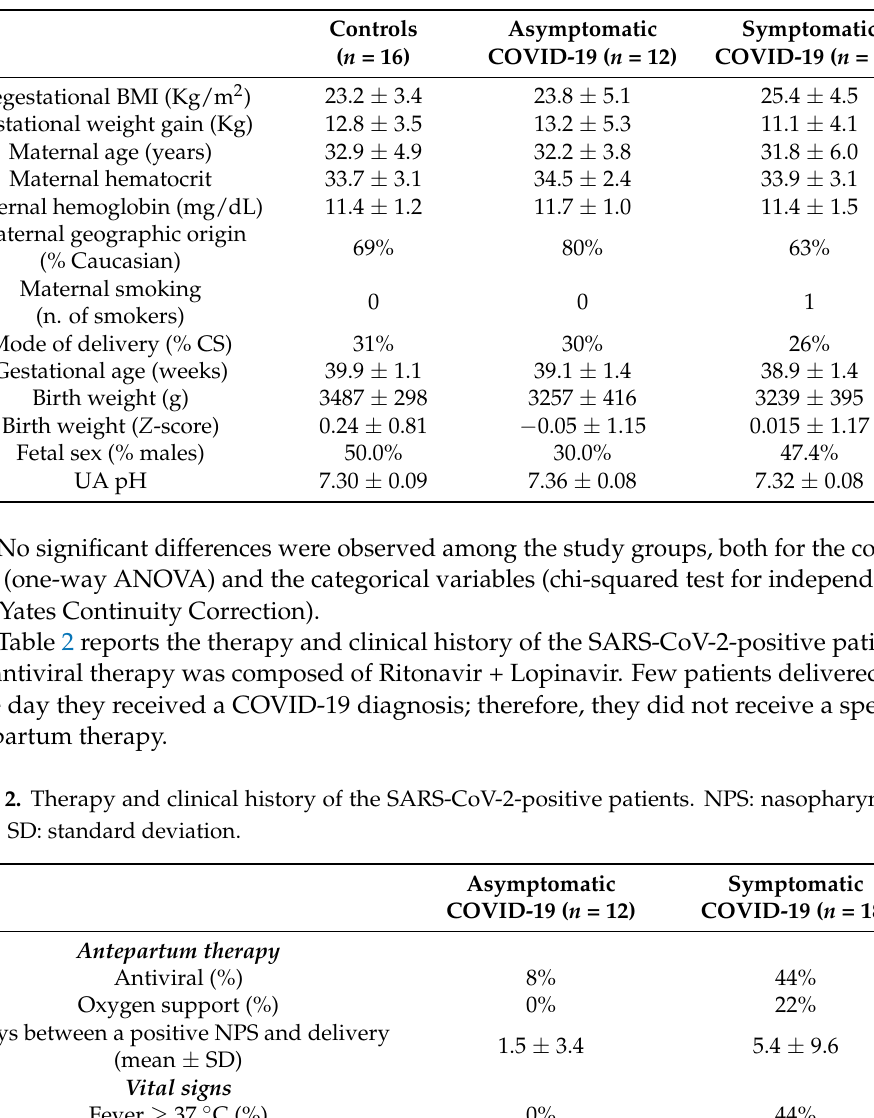
Table 1. Clinical characteristics of the population. Values are presented as mean ± standard deviation. BMI: Body mass index; CS: cesarean section; UA: umbilical artery.